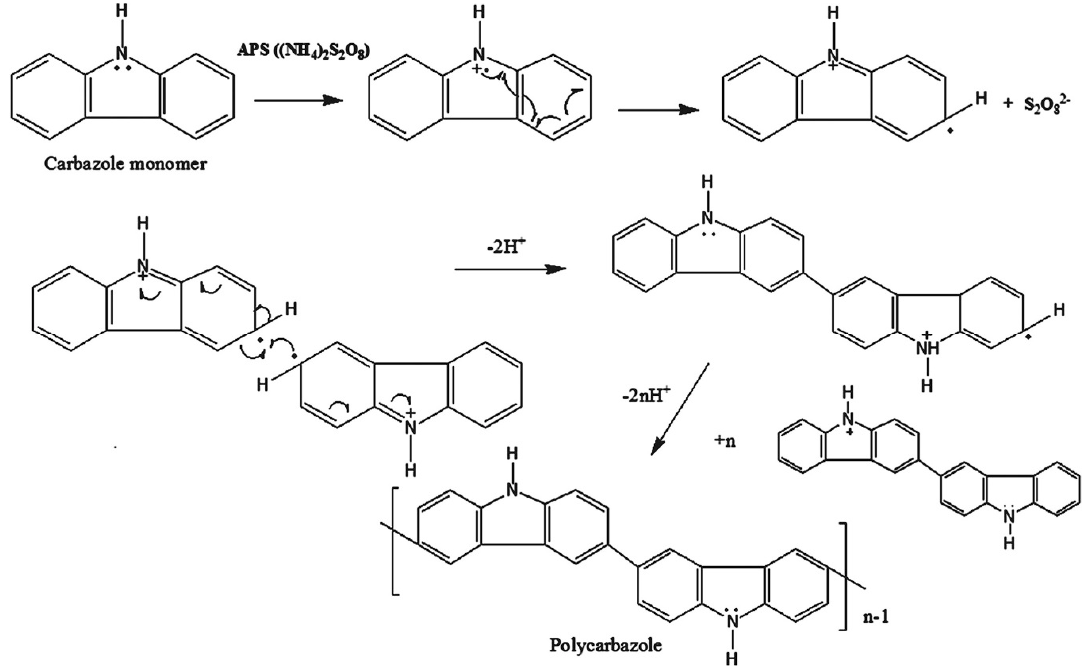
Figure 4. Proposed mechanistic scheme for the synthesis of carbazol-based polymers (PCz). Reprinted with permission from Sangwan et al. [99]. Copyright (2016) Wiley.